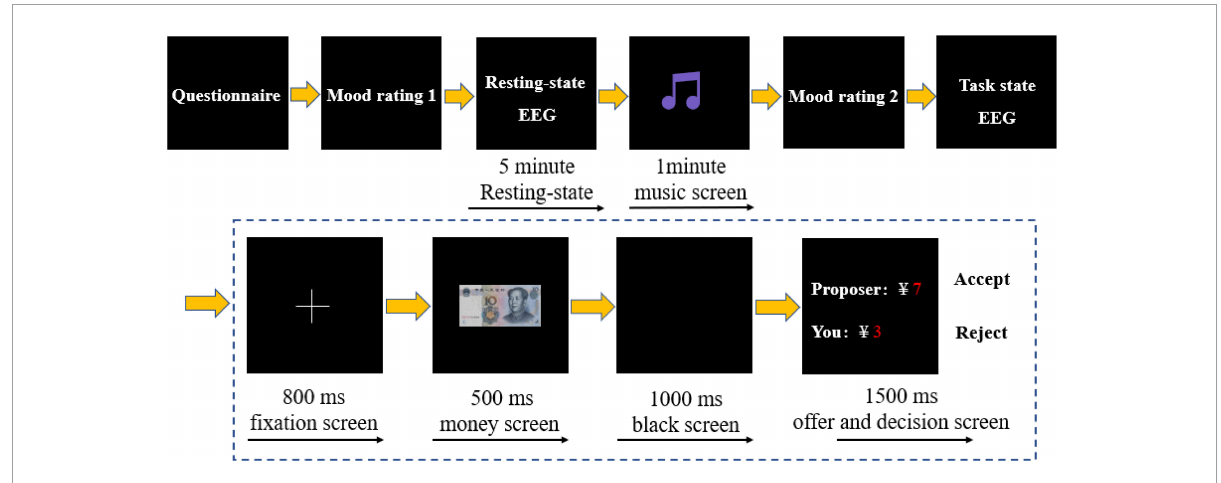
FIGURE1 The experimental